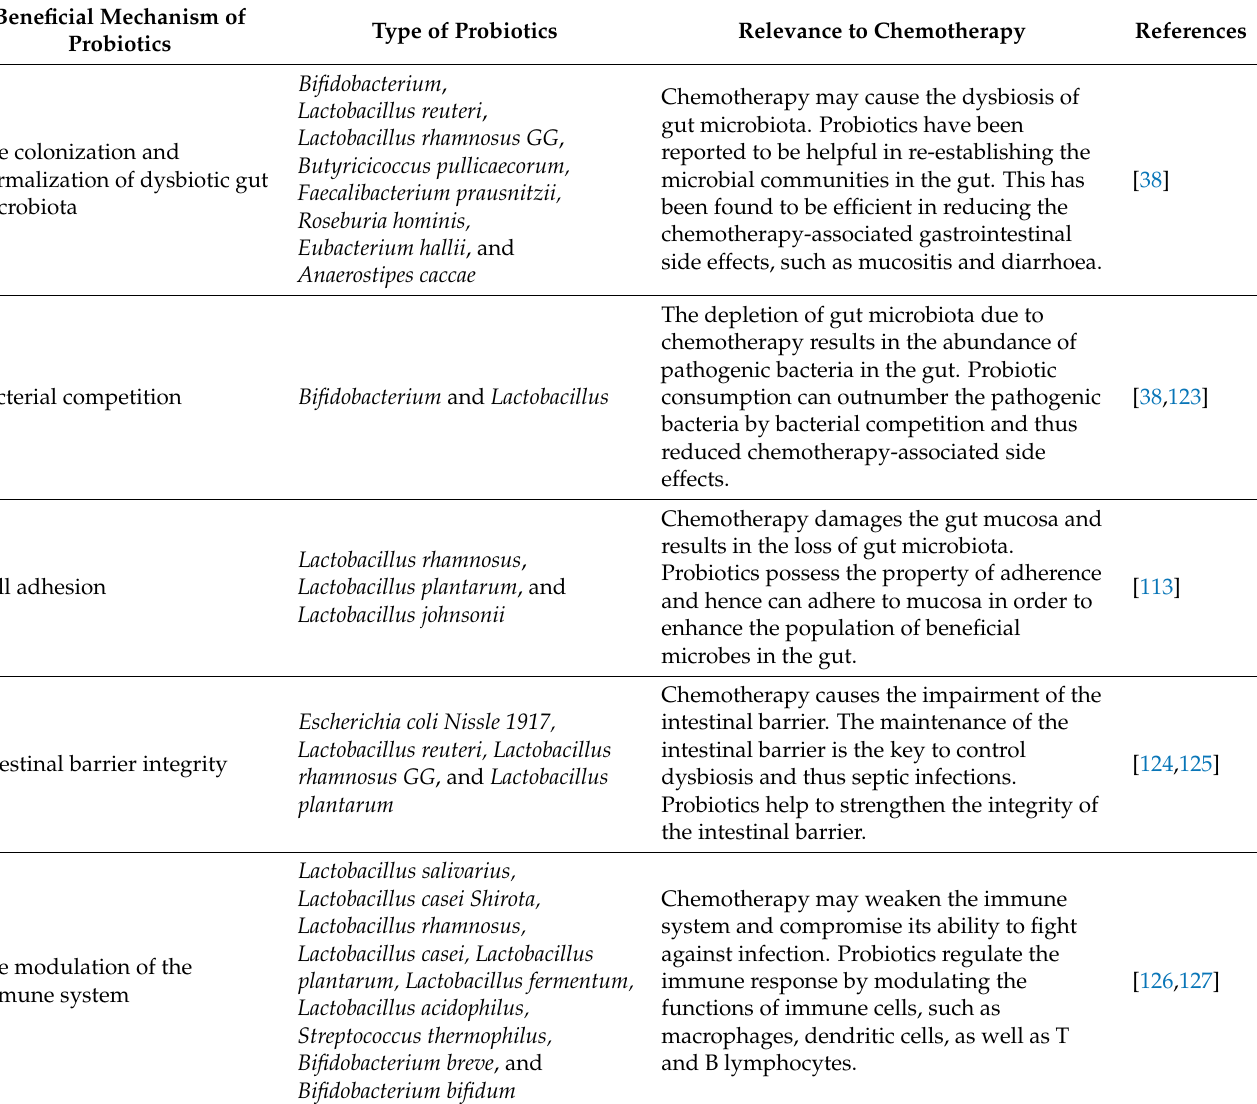
Table 2. The beneficial mechanisms of probiotics and their relevance to